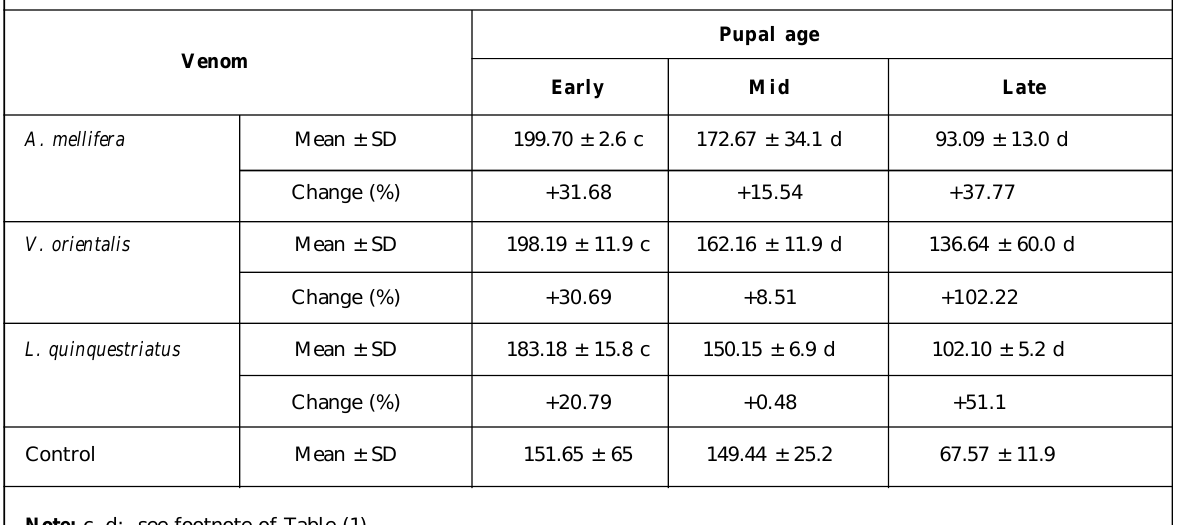
Table 4: Influenced total lipid content (mg/g) in the pupal tissues after treatment of the 3 rd instar larvae of values of certain arthropod venoms G. mellonella with LC 50